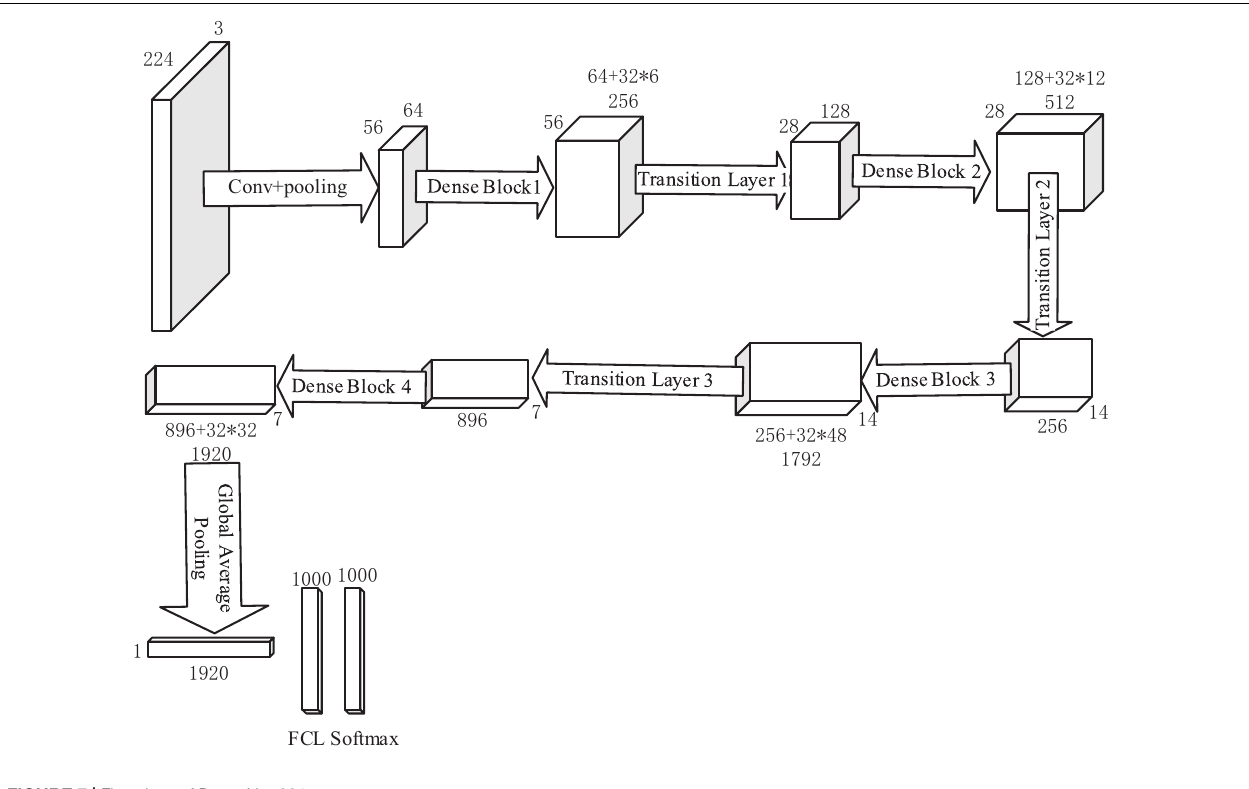
FIGURE 7 | Flowchart of DenseNet